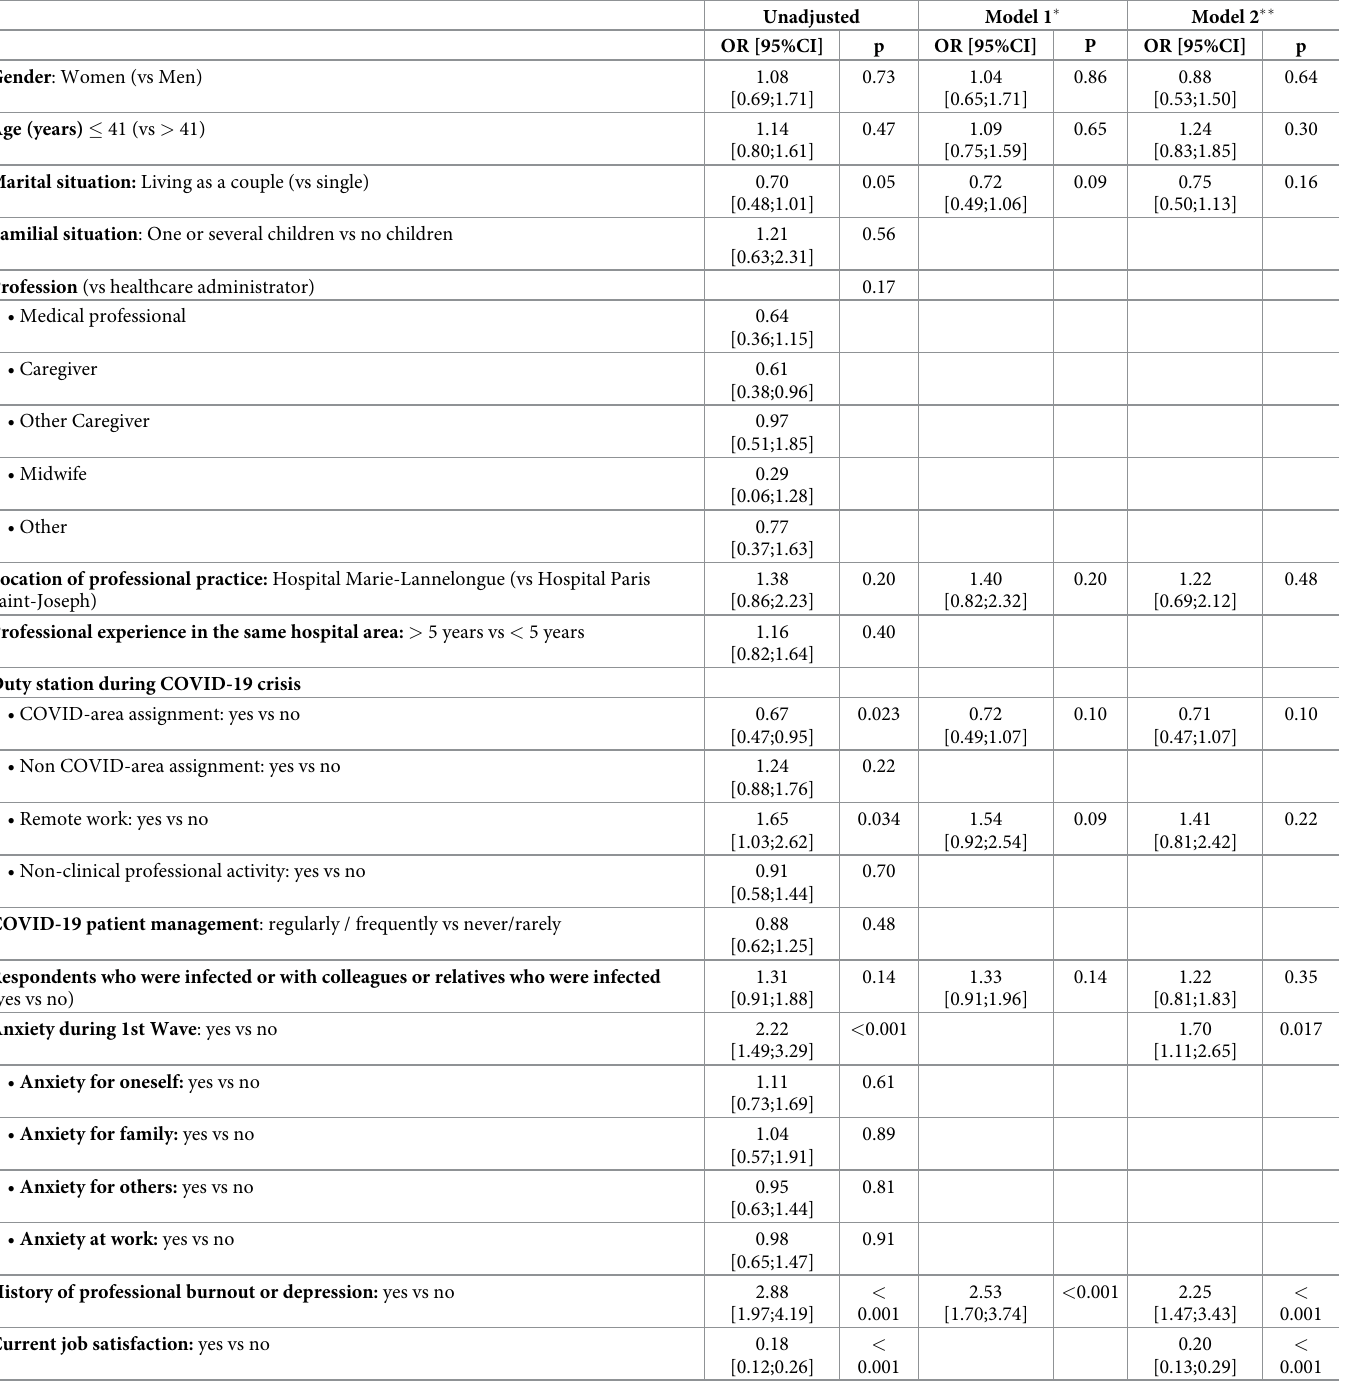
Table 3. Unadjusted and adjusted logistic regression for symptoms of depression (HADd > 7), n =